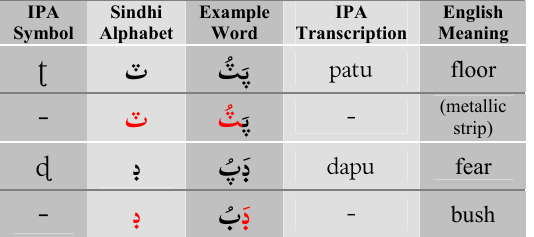
Table: Two new consonant phonemes suggested by